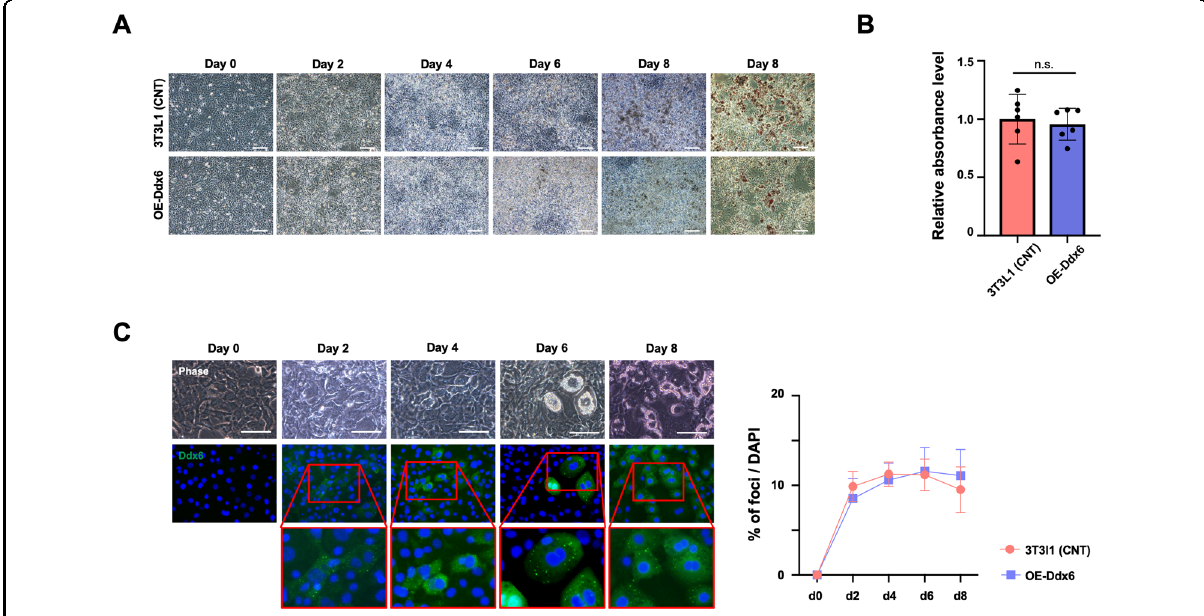
Fig. 4 Adipogenic differentiation of Ddx6-O/E 3T3L1 preadipocytes. A Phase-contrast microscopic images during adipogenesis. On day 8, the cells were fi xed and stained with oil red O. The scale bar is 100 μ m. B Relative absorbance of oil red O. The error bars indicate the SDs ( n = 6). C Fluorescence microscopy images and the proportion of cells with foci during adipogenesis are shown. The scale bar is 100 μ m. The error bars indicate the SDs ( n = 6). The nuclei were stained with Hoechst